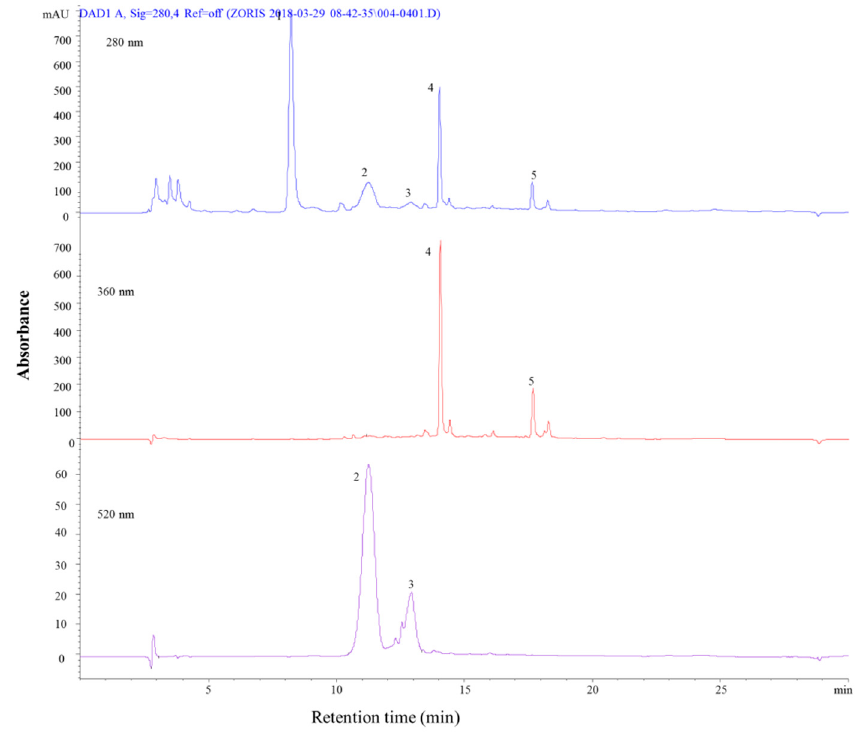
Figure 4. HPLC-PDA chromatograms of red onion recorded at 280, 360, and 520 nm.